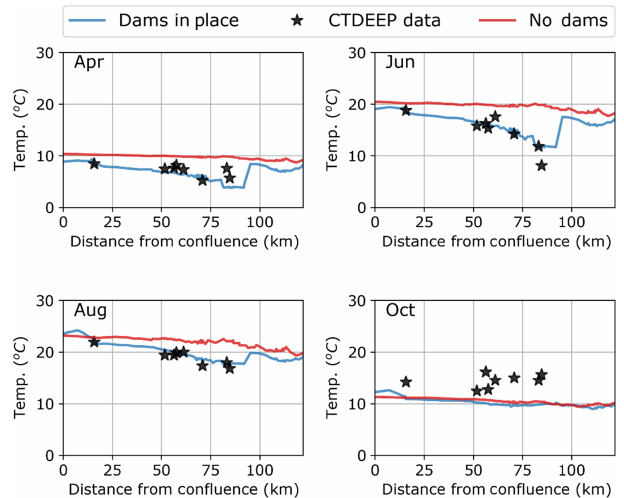
Figure 7. Monthly-averaged stream temperatures of April, June, August and October in the West Branch and main stem of the Farm- ington River for the following: dams in place – existing riparian shading and water management projects; no dams – removal of wa- ter management projects maintaining existing riparian shading; and monthly-averaged water temperatures at locations monitored by the Connecticut Department of Energy and Environment (CTDEEP).